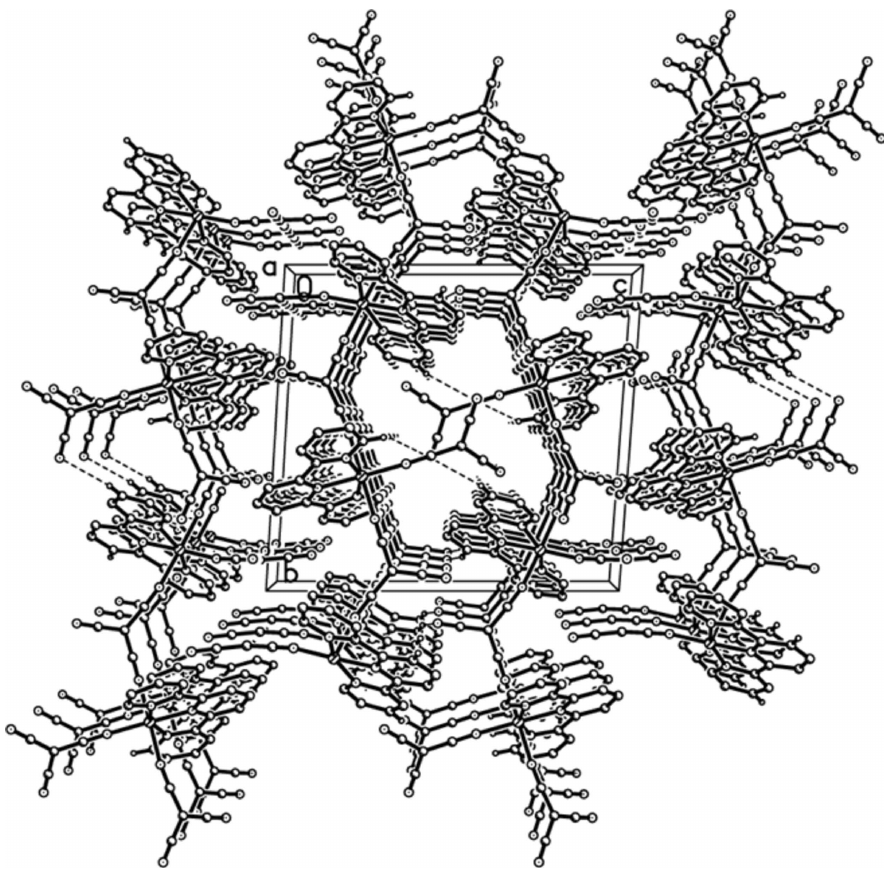
Figure 2 The three-dimensional network structure of (I) formed via terpy π - π interactions and hydrogen bonding interactions, viewed along the a